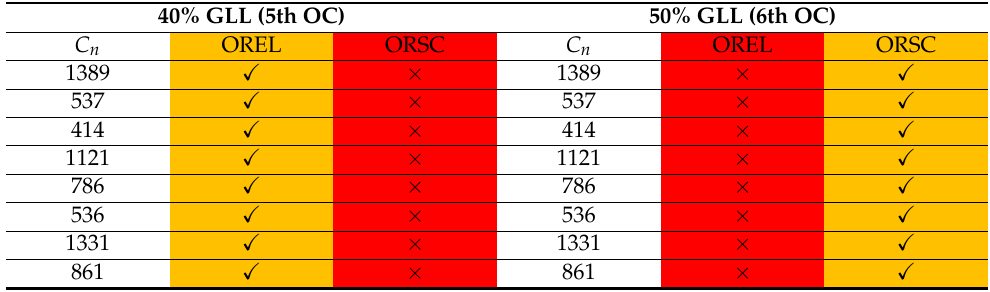
Figure 7. Interrelation between different operational risk definitions. Table 1. OREL: Contingencies comparison under two operating conditions, where the yellow color indicates that these contingencies are contributing to the operational risk and the red color that they are not contributing.